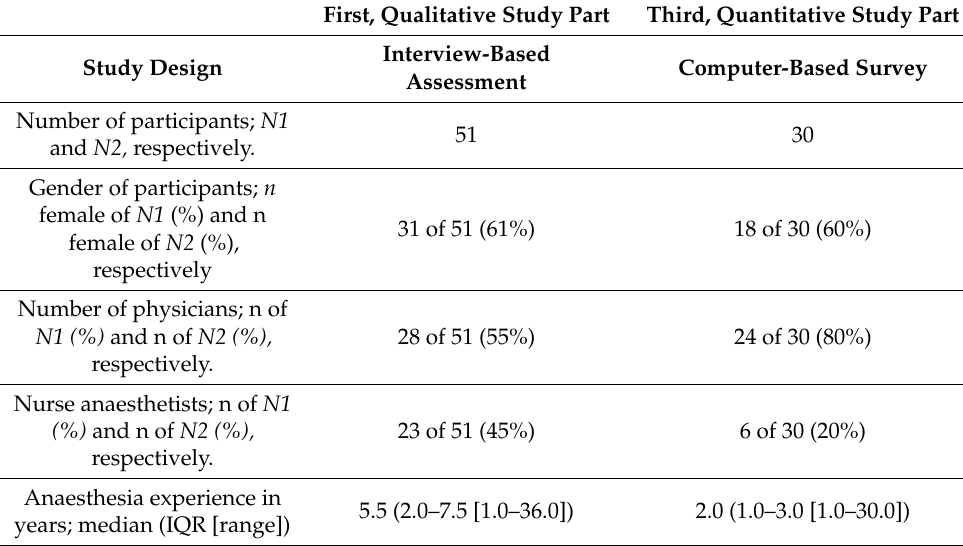
Table 1. Study and participant characteristics.